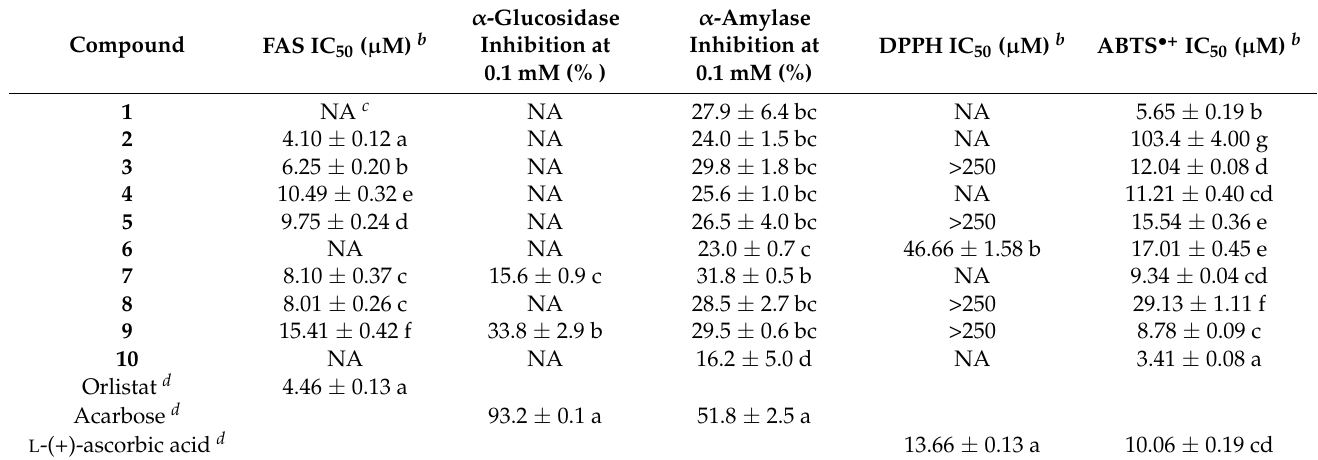
Table 5. Results of the bioactivity assays of compounds 1 – 10 from L. robustum a